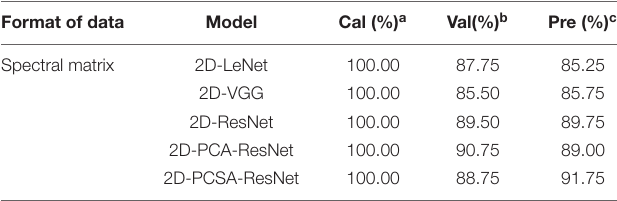
TABLE 1 | The results of discriminant models based on single spectrum and a majority vote. Model TABLE 2 | The results of 2D-CNNs based on a spectral